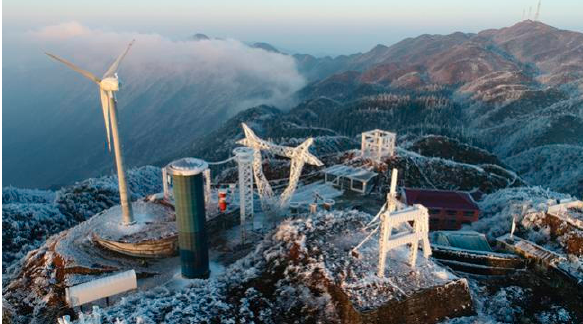
Figure 1. Xuefeng mountain natural icing test base.